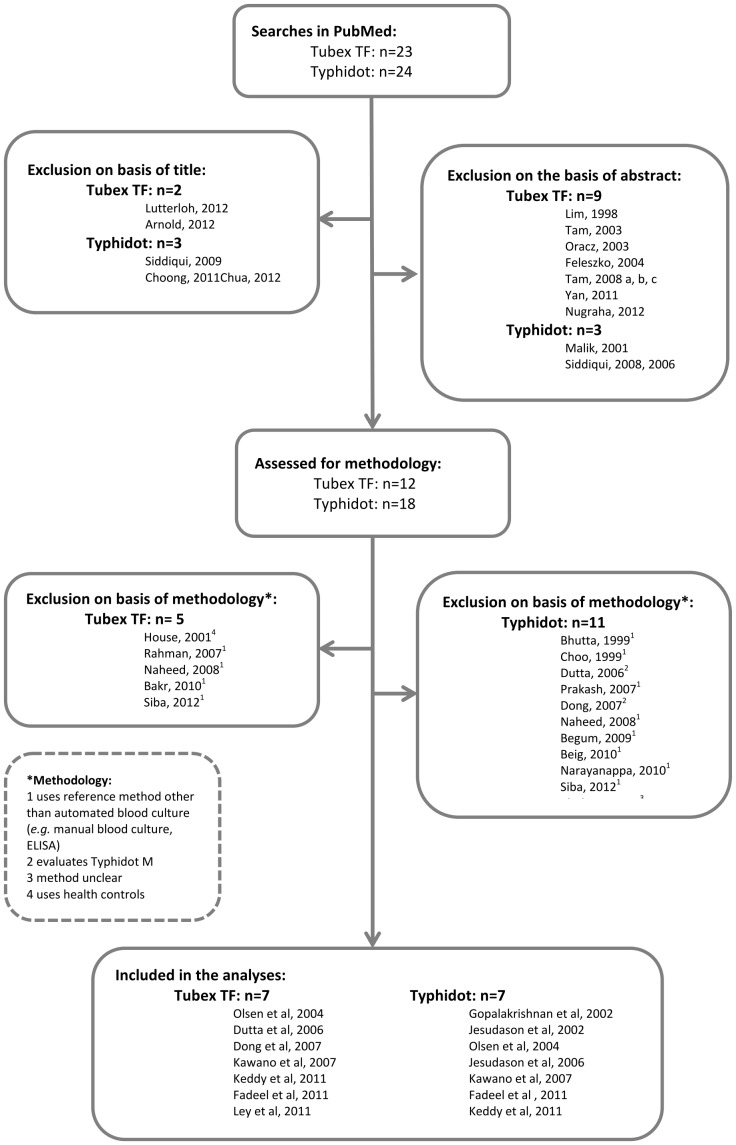
Selection of studies included in the analyses.